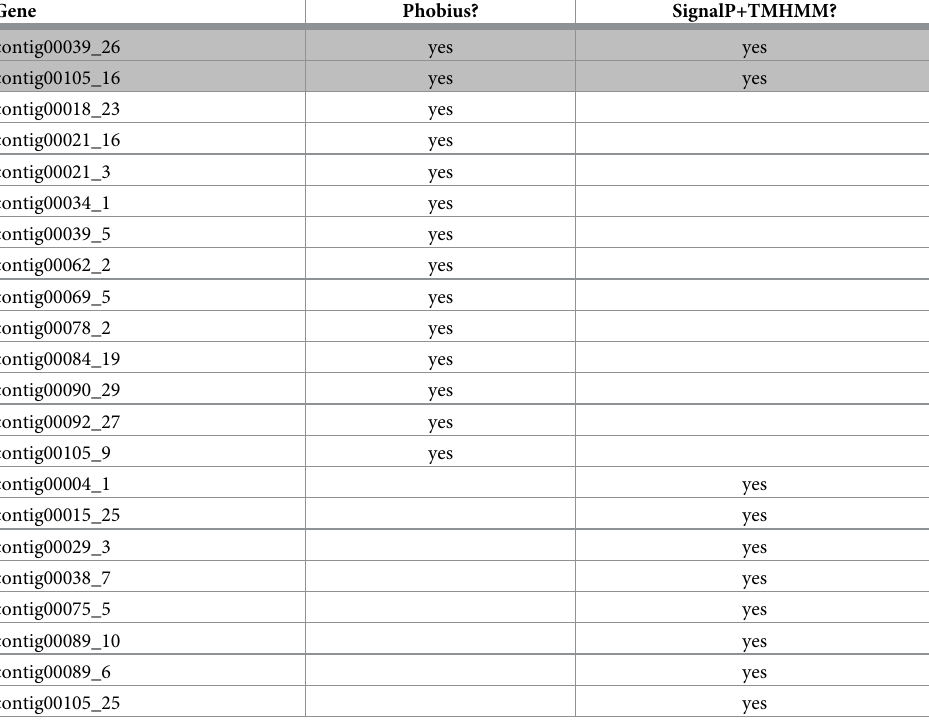
Table 6. Non-membrane bound secreted protein candidates in NJAY lacking evident homology with such pro- teins in AY-WB.